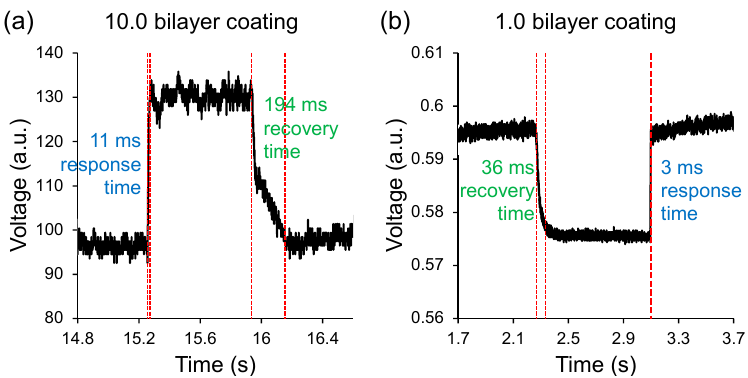
Figure 20. Temporal characteristics of ( a ) 10.0 bilayer coated sensor head; and ( b ) 1.0 bilayer coated sensor head.